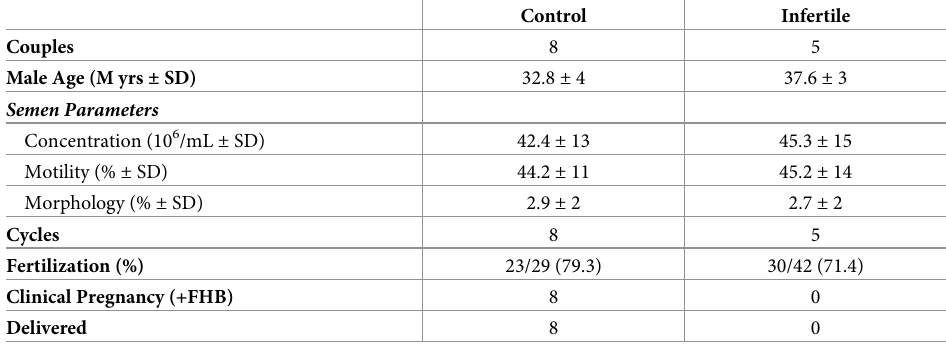
Table 3. Couples’ demographic, gamete characteristics and pregnancy outcome.